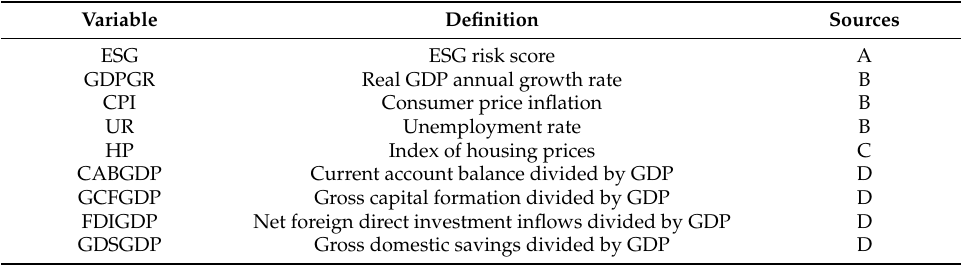
Table 2. Early warning